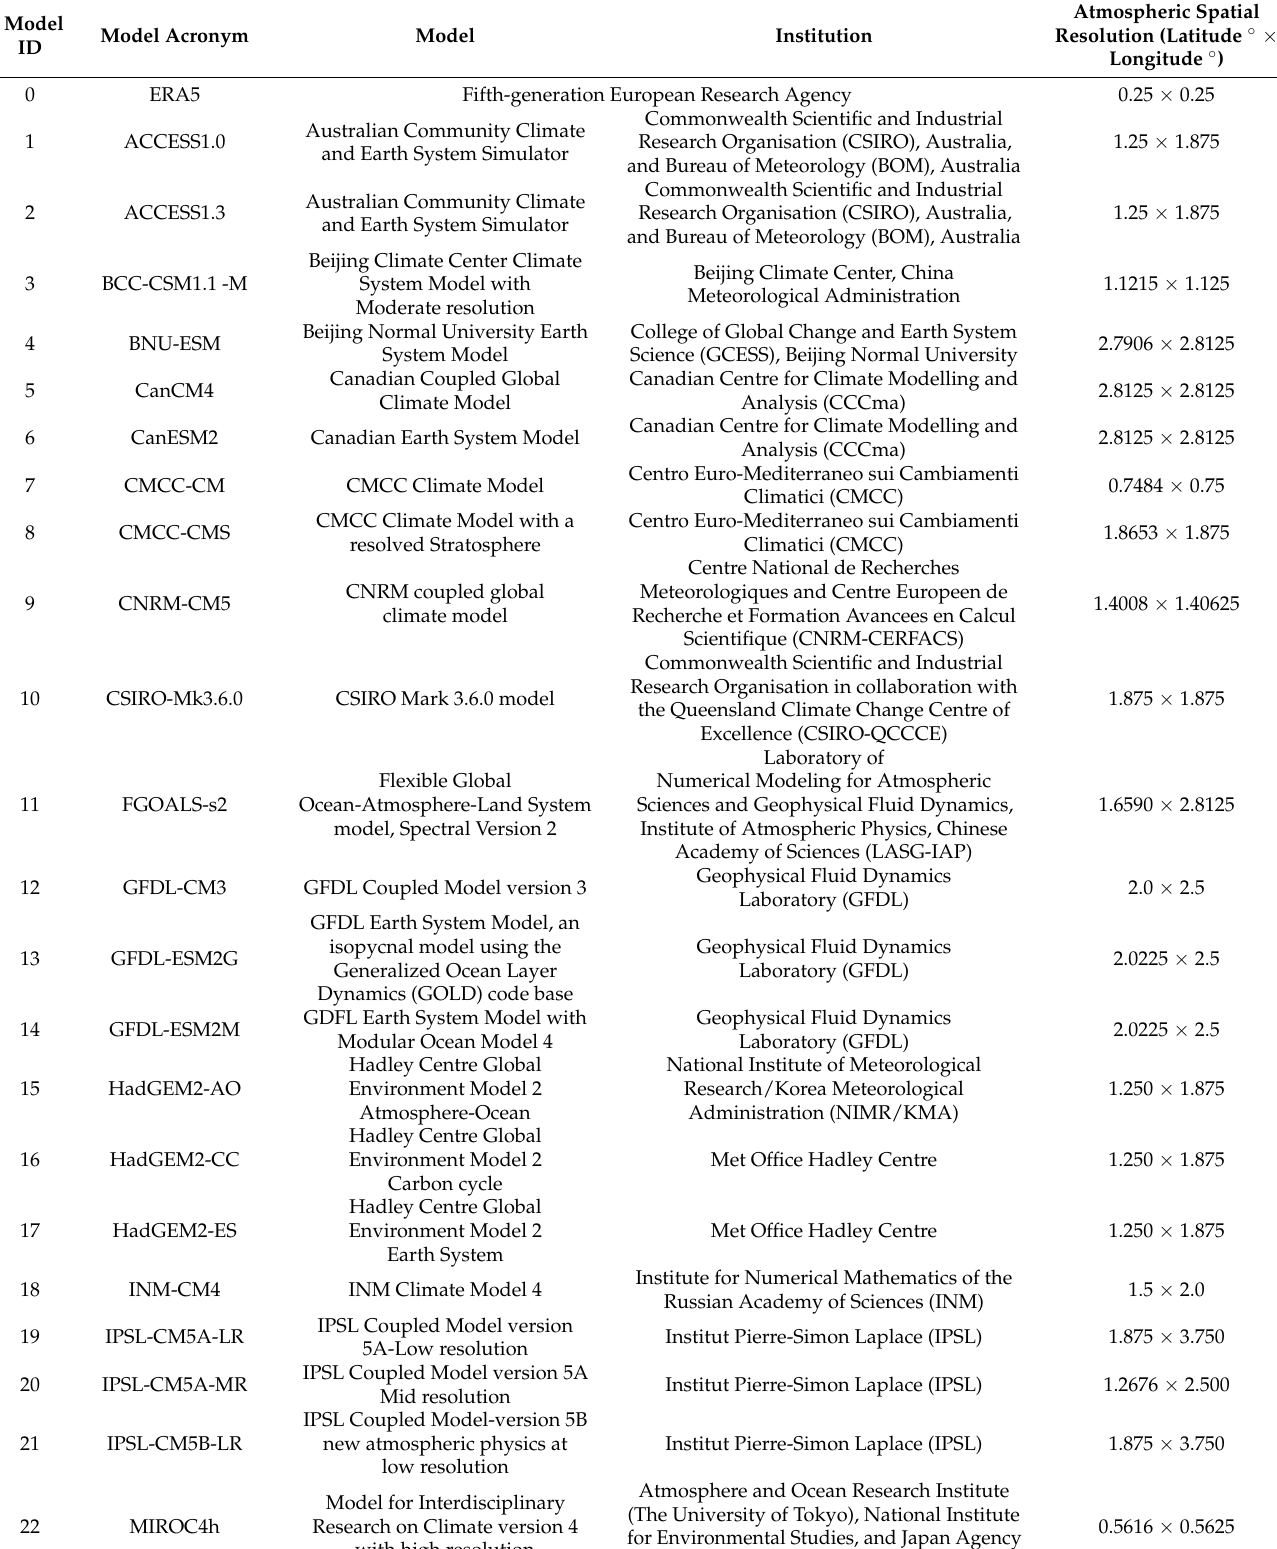
Table 1. Attributes of CMIP5 GCMs and